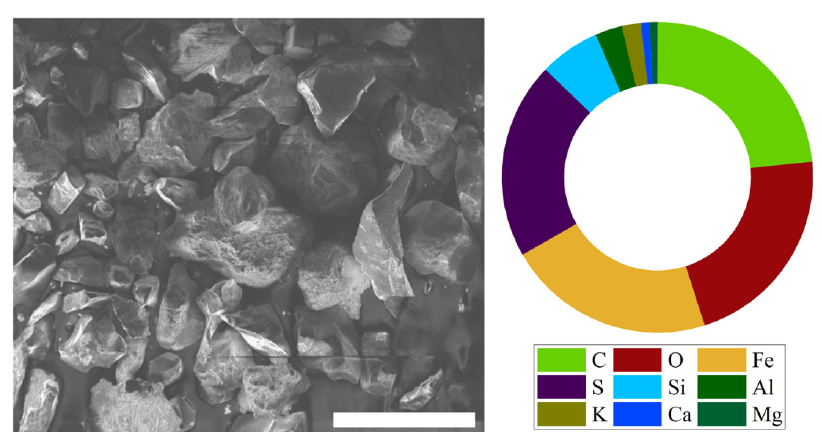
Figure 5. SEM micrograph, ( a ) before roasting, and ( b ) after roasting at 500 °C for 2 h.